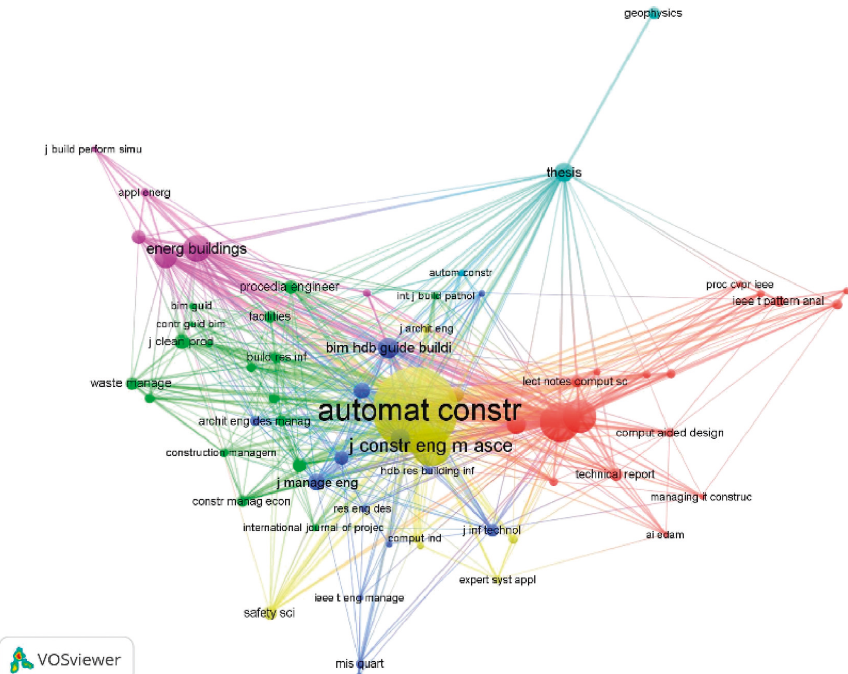
Figure 3: The main outlet networks describing the “ Automation in Construction ” as the most effective journal on the topic of integration in BbCNs.